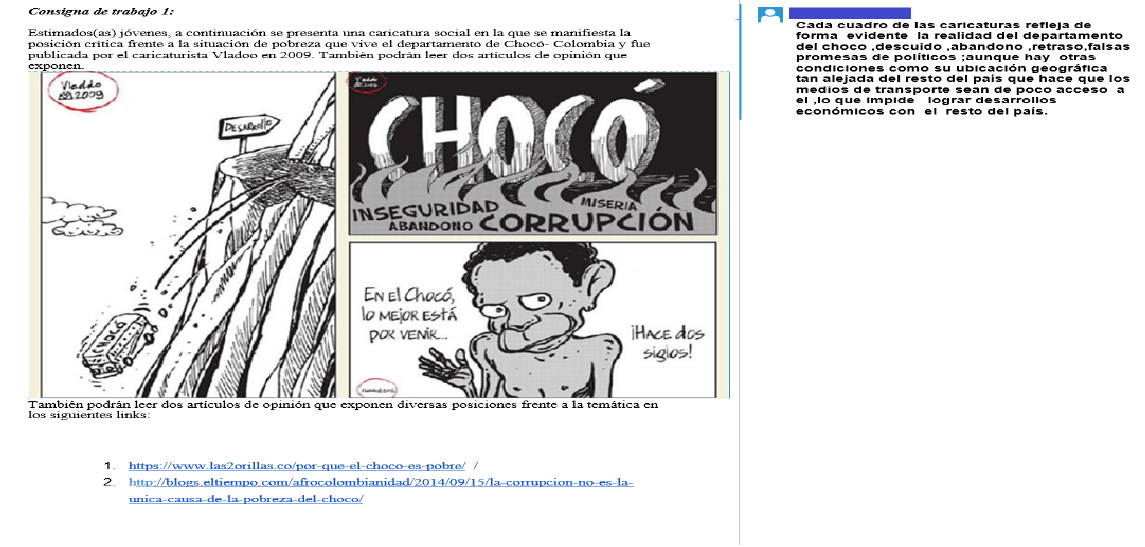
Guidelines and Reference Texts for the